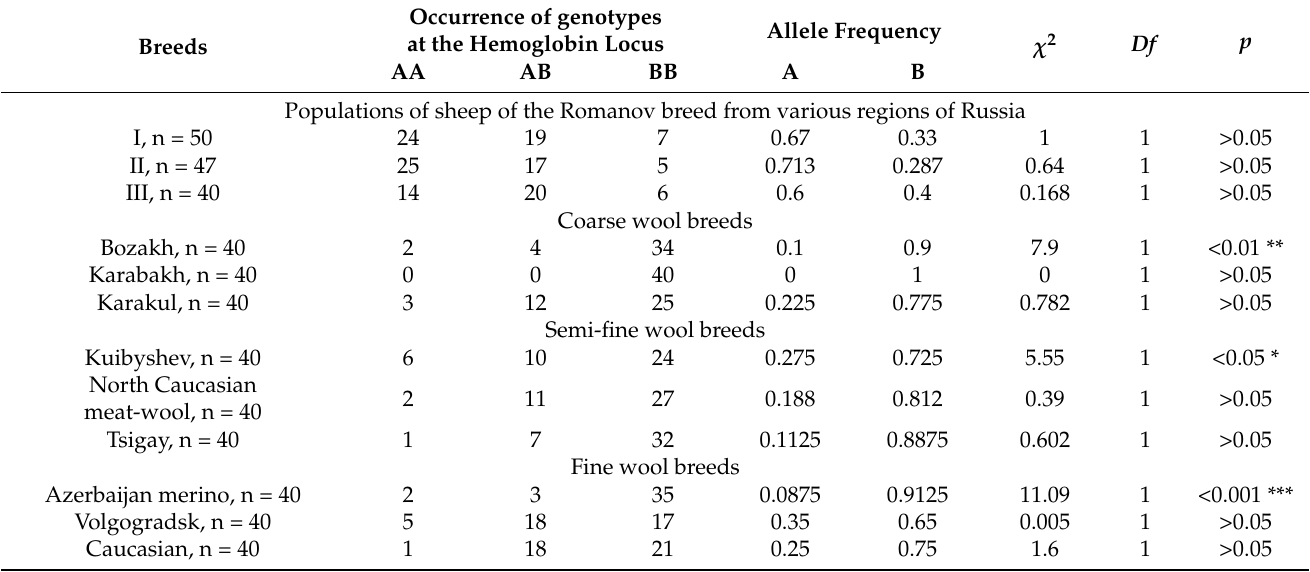
Table 5. Comparative analysis of the state of the hemoglobin locus ( HB ) in sheep of various breeds in Russia, Azerbaijan and Moldova (n = 497). Conformity to Hardy–Weinberg was tested by χ 2 tests.